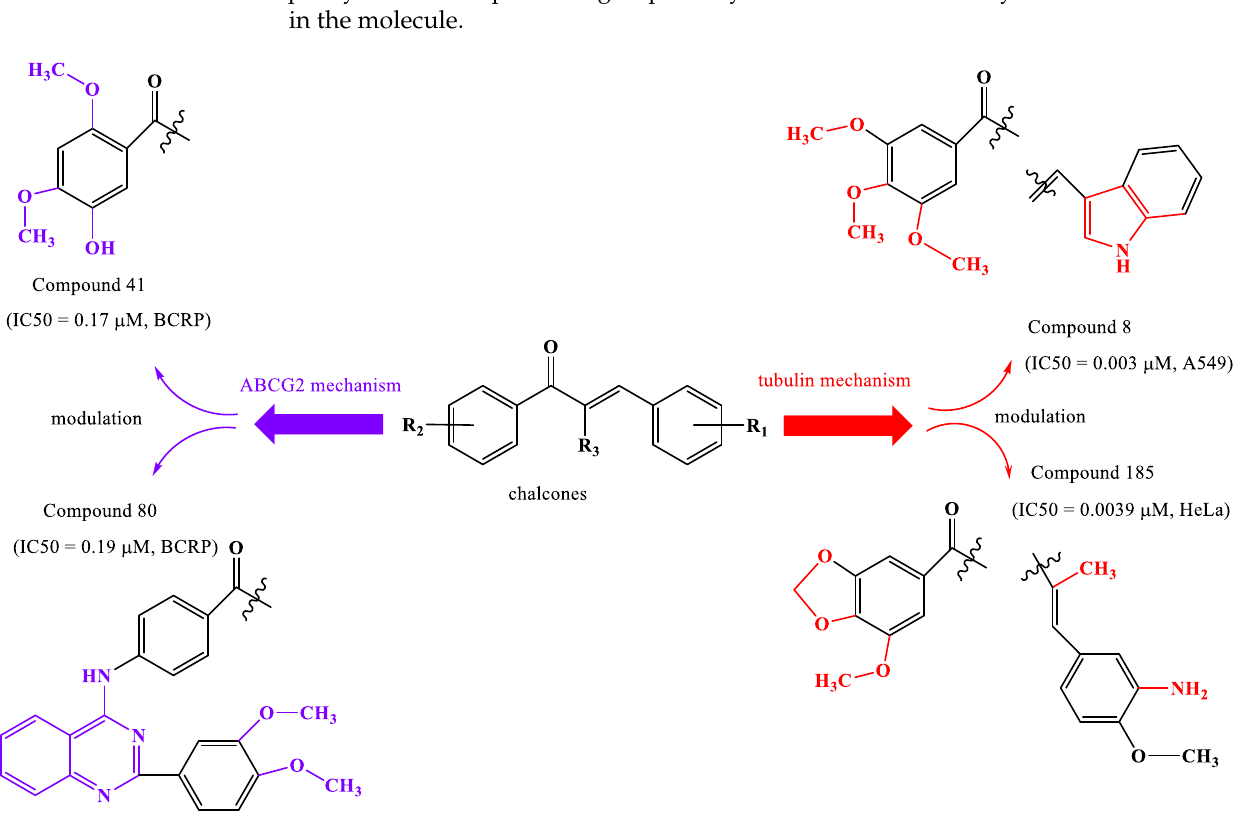
Figure 13. The two mechanisms and most active compounds.